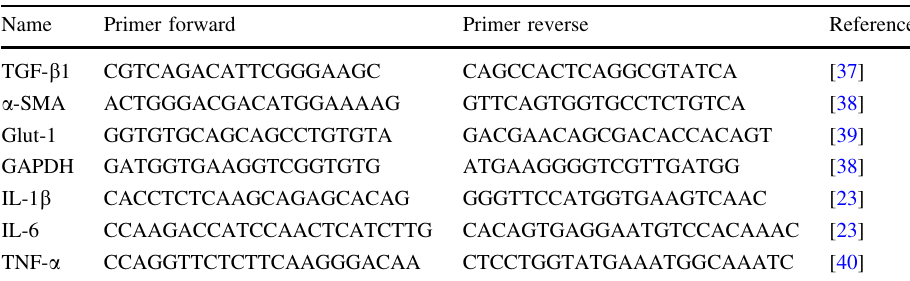
Table 1 Primer sequences for quantitative real-time PCR